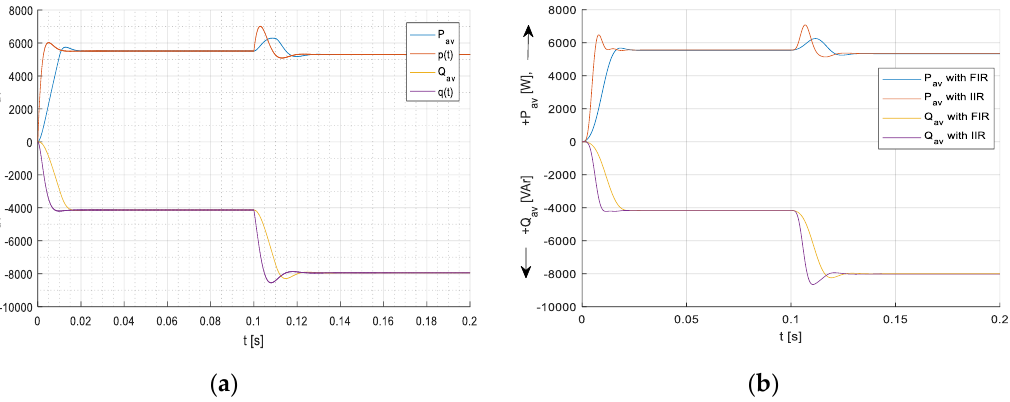
Figure 4. Comparison of power waveforms calculated by different methods MAF and direct function in the time domain 𝑝(𝑡) and 𝑞(𝑡) — ( a ), DFIR and DIIR filters for 𝑃 𝑎𝑣 (𝑘) and 𝑄 𝑎𝑣 (𝑘) — ( b ).